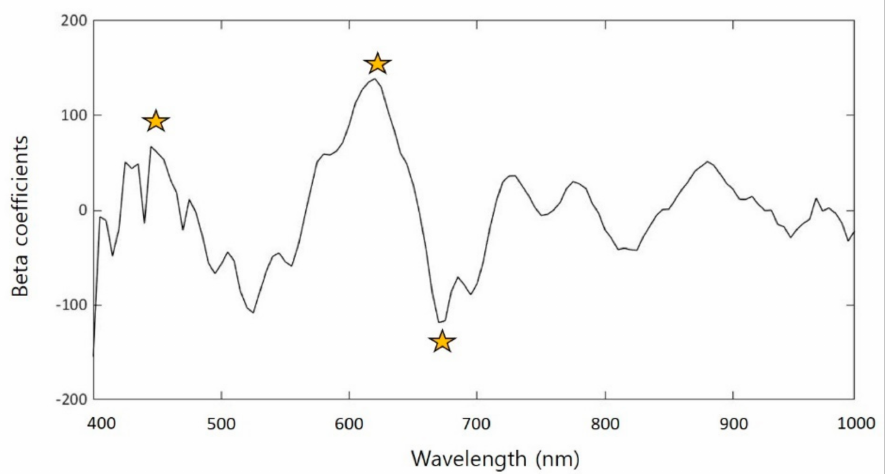
Figure 5. PLS model beta-coefficient plot for FWC detection in OF mixture